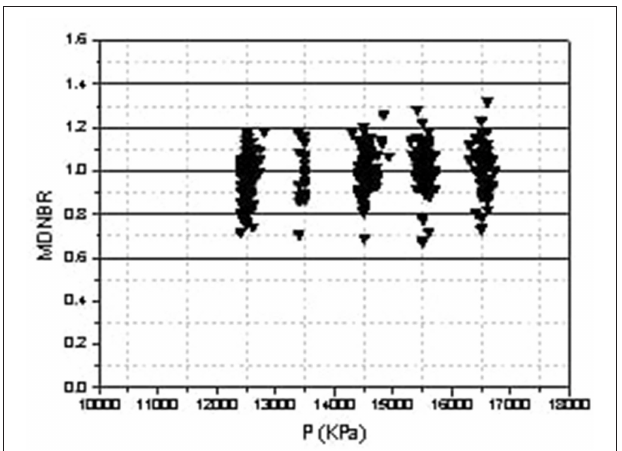
FIGURE 7 | Variation of predicted MDNBRs with pressure.